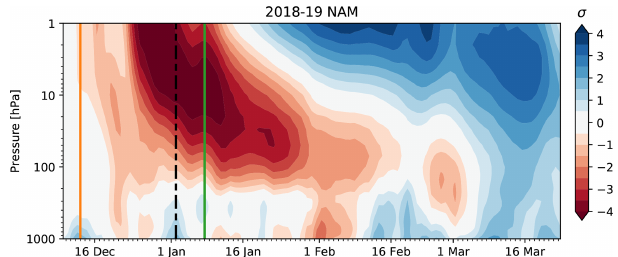
Figure 7. NAM indices during the January 2019 boreal major warming. The vertical dashed–dotted black line indicates the date of the wind reversal at 10hPa, 60 ◦ N. The vertical green and orange lines indicate the requested initialization dates.